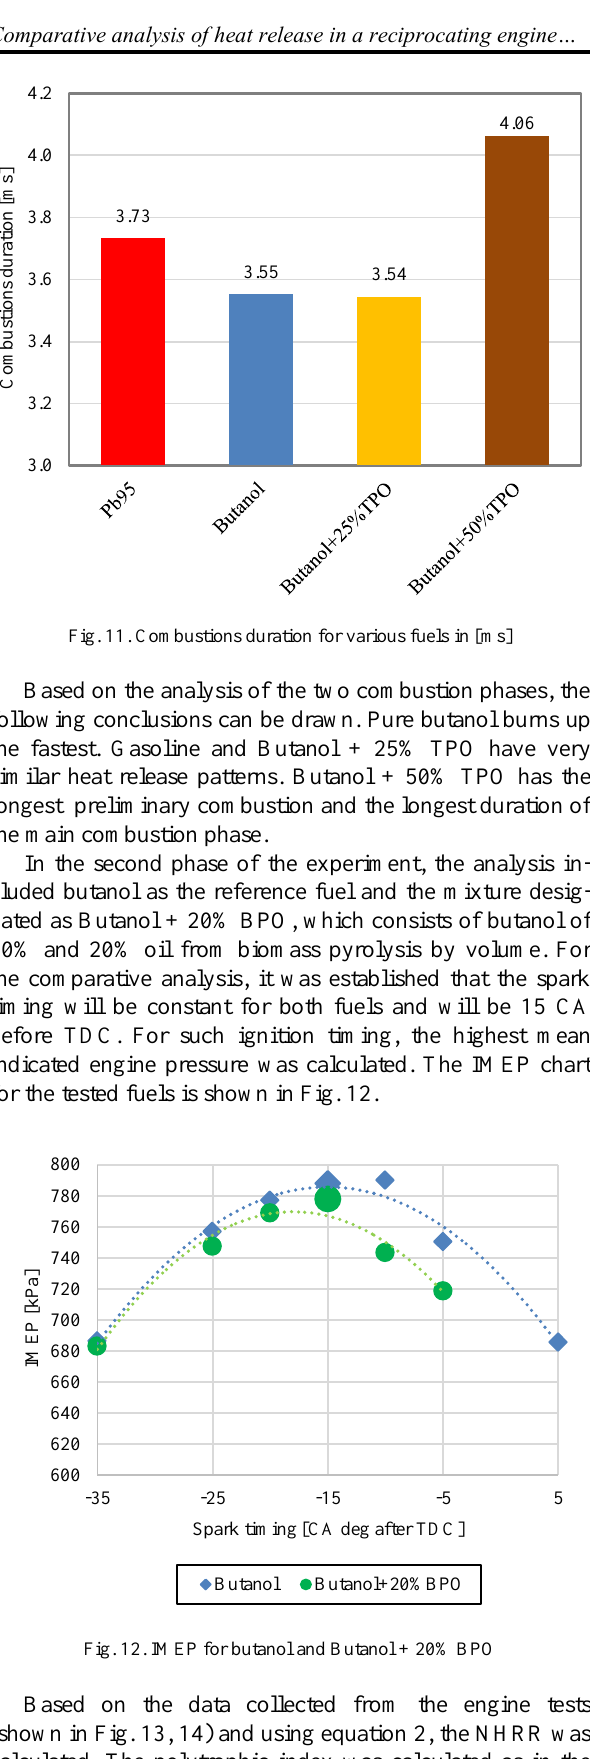
Fig. 15. The net heat release rate for butanol and Butanol + 20%